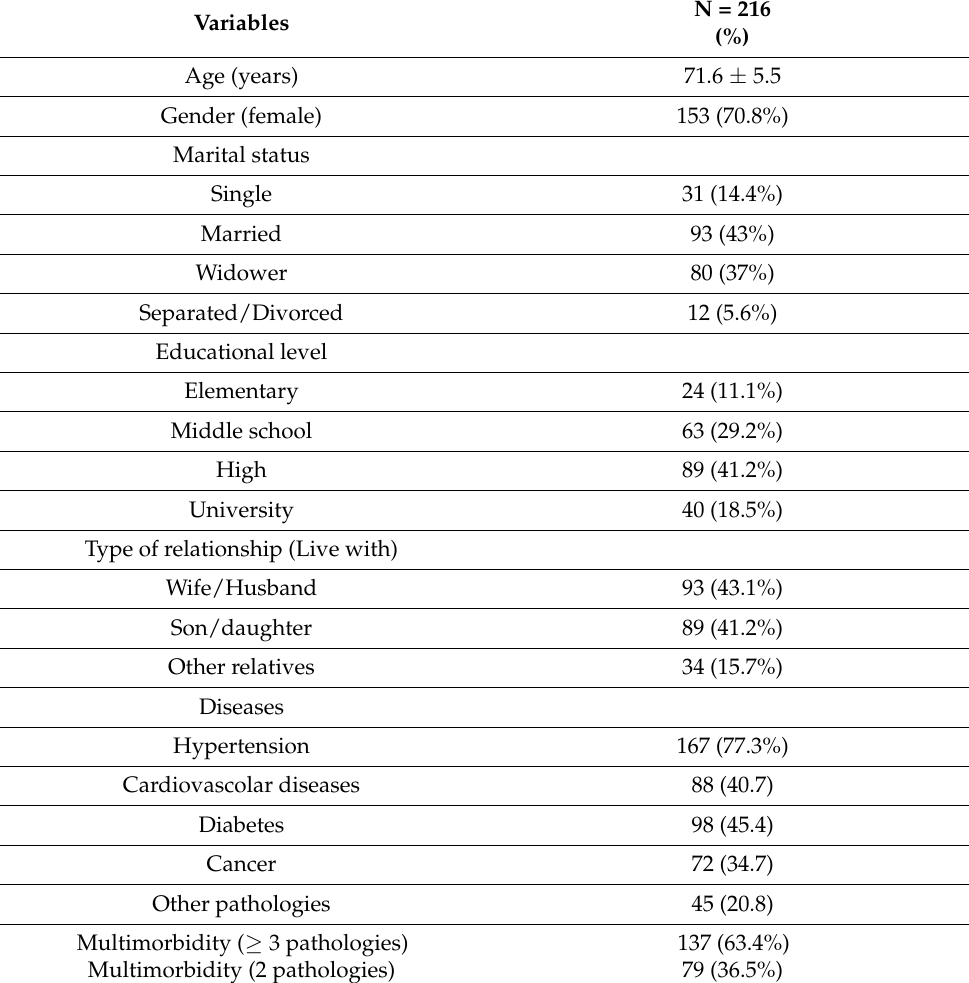
Table 1. Characteristics of